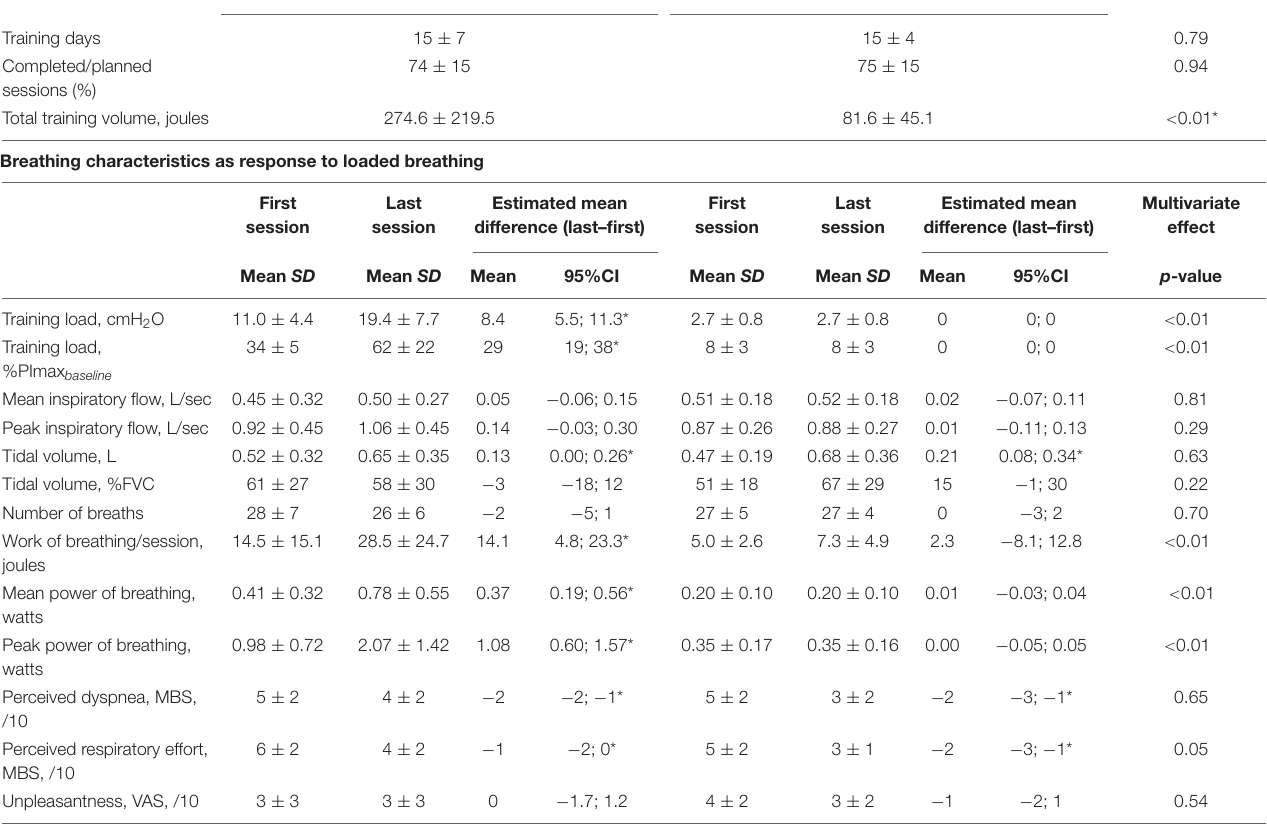
TABLE 2 | Training data and breathing characteristics during the first and last inspiratory muscle training session. Intervention group, high-intensity IMT ( n = 22) Control group, sham low-intensity IMT ( n = 19) Between group Mean SD Mean